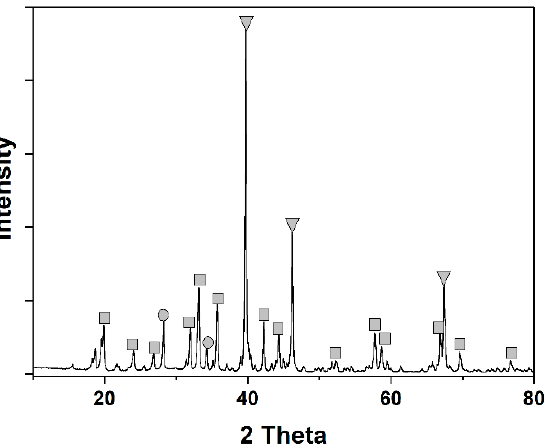
Figure 3. XRD analysis of the Pt/barium hexaaluminate: Ba 0.83 Al 11 O 17.33 ( ■ ), BaAl 2 O 4 ( ● ), and Pt ( ▼ ).